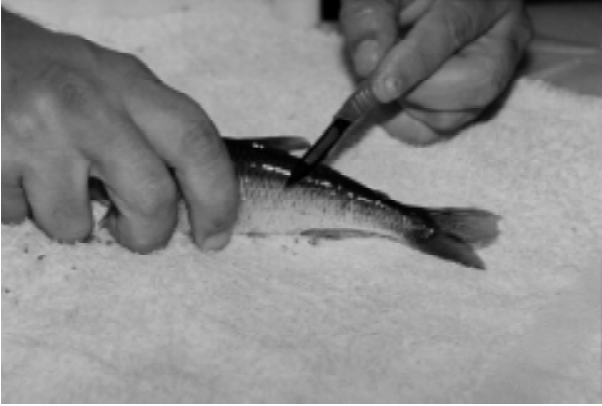
Figure 1 - Surgical blade position mid-way between dorsal and adipose fins for transversal cut procedure.